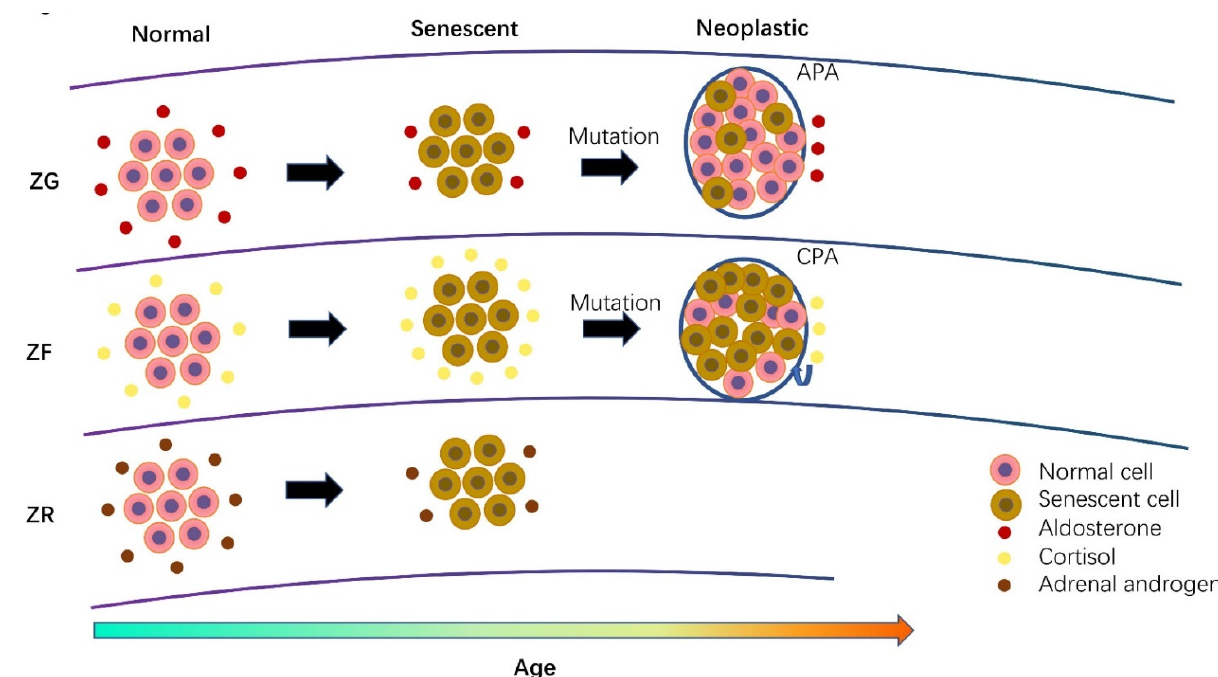
Figure 4. The role of cellular senescence in hormonal function of the adrenal cortex during aging. ZG, ZF and ZR cells have similar senescent phenotypes during aging. However, the effect of senescence on hormonal function is different among these three cells. We proposed that cellular senescence may suppress aldosterone and adrenal androgen production but not cortisol production. Therefore, aldosterone and adrenal androgen production are gradually reduced, whereas cortisol production tends to gradually increase during aging. When a neoplastic nodule develops due to genetic disorders, both aldosterone-producing adenoma (APA) and cortisol-producing adenoma (CPA) can autonomously biosynthesize and secrete aldosterone and cortisol. This autonomous overproduction of steroids also reinforces a local or in situ senescent phenotype resulting in a more senescent phenotype in CPA than that in APA. The role of cellular senescence in adrenal androgen producing adenoma has rarely been explored and remained unknown.